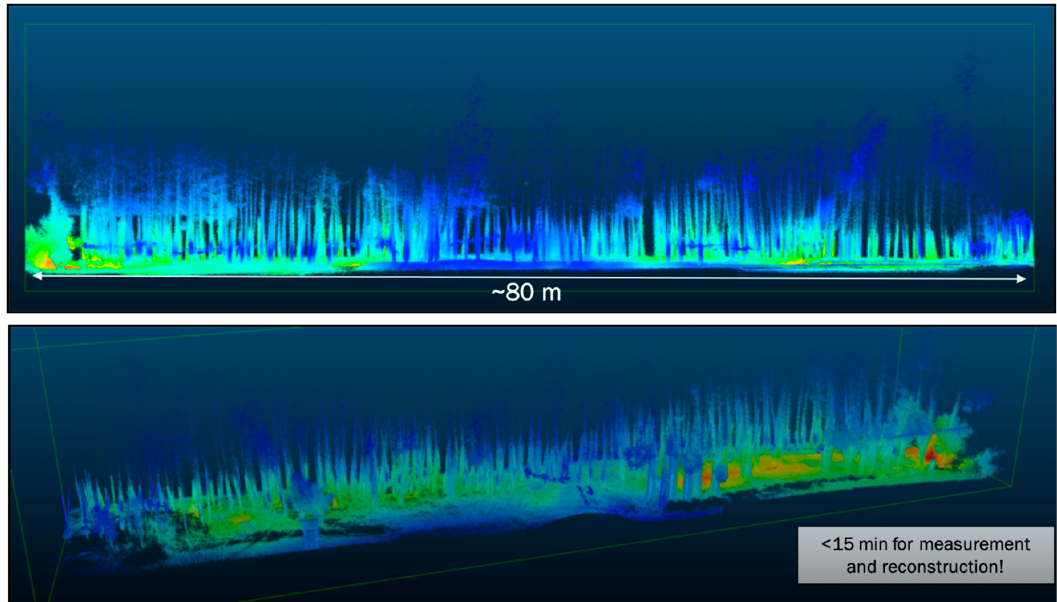
Figure 4. ( Top ) Fused nuclear scene maps in a contaminated bamboo forest in Fukushima Prefecture.